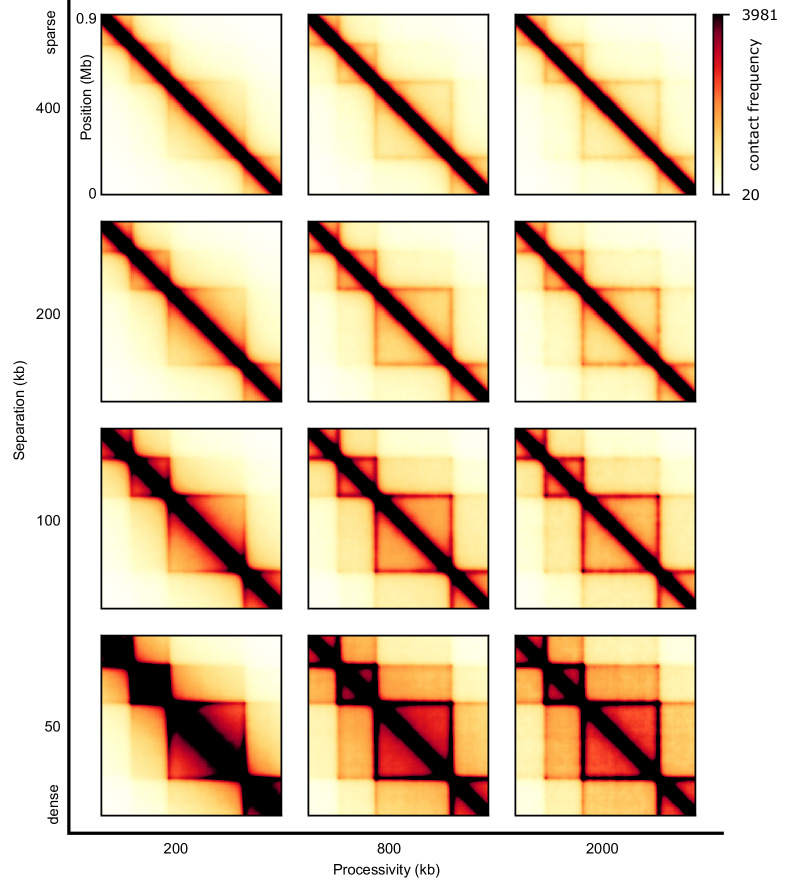
Sweep of the separation and the processivity of LEFs for one-sided LEFs that may traverse each other.The TADs are 200 kb and 400 kb in size.